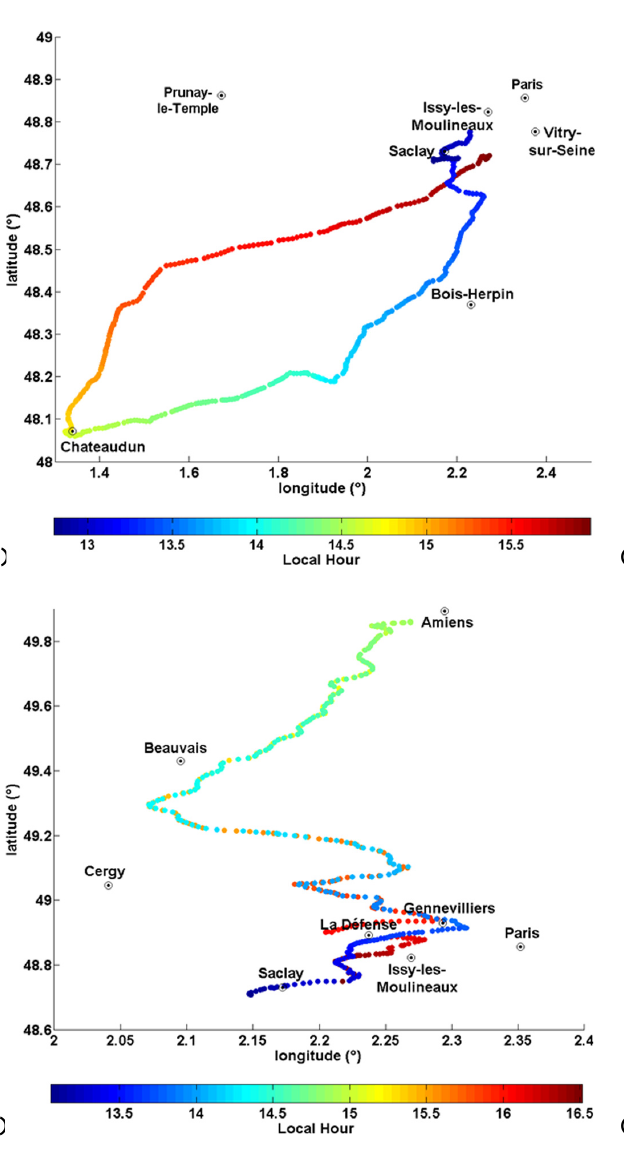
Fig. 2. Lidar van-circuits performed during the MEGAPOLI summer experiment for the 1 (a) , 15 (b) , 16 (c) and 26 (d) July 2009. The color scale indicates the decimal hours in